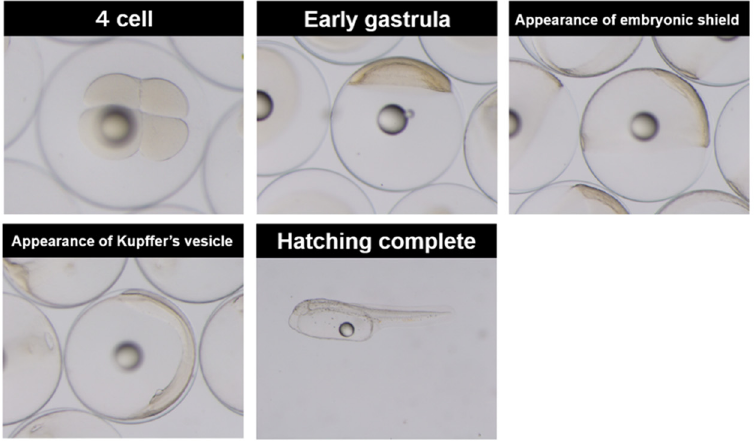
Figure 1. The morphological alterations with the development of yellowfin tuna eggs and yolk sac